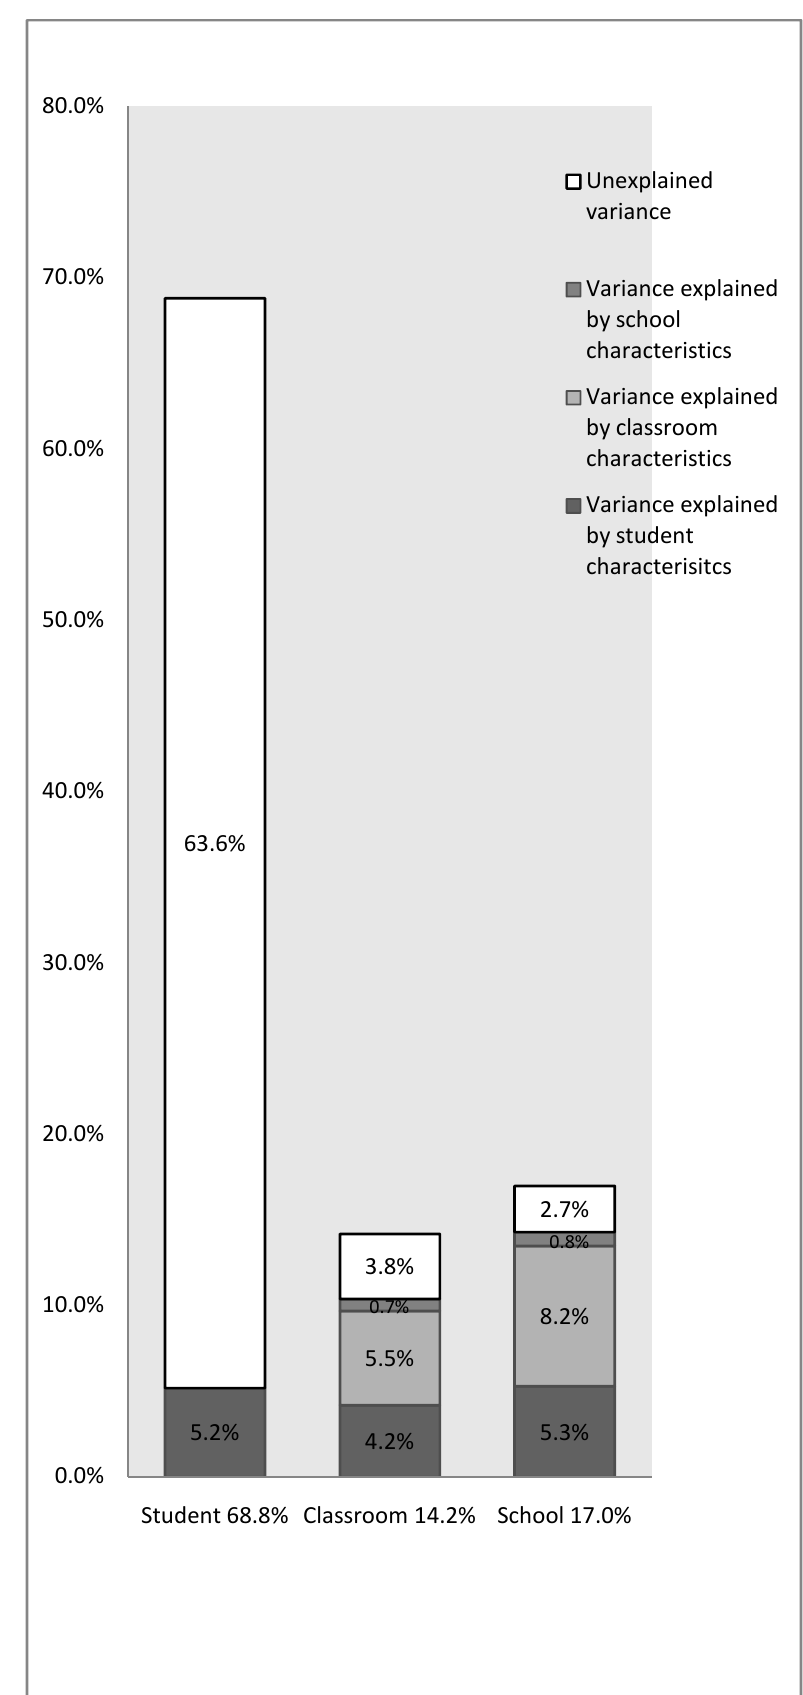
Figure 1 Variance in Math achievement explained by student, class and school